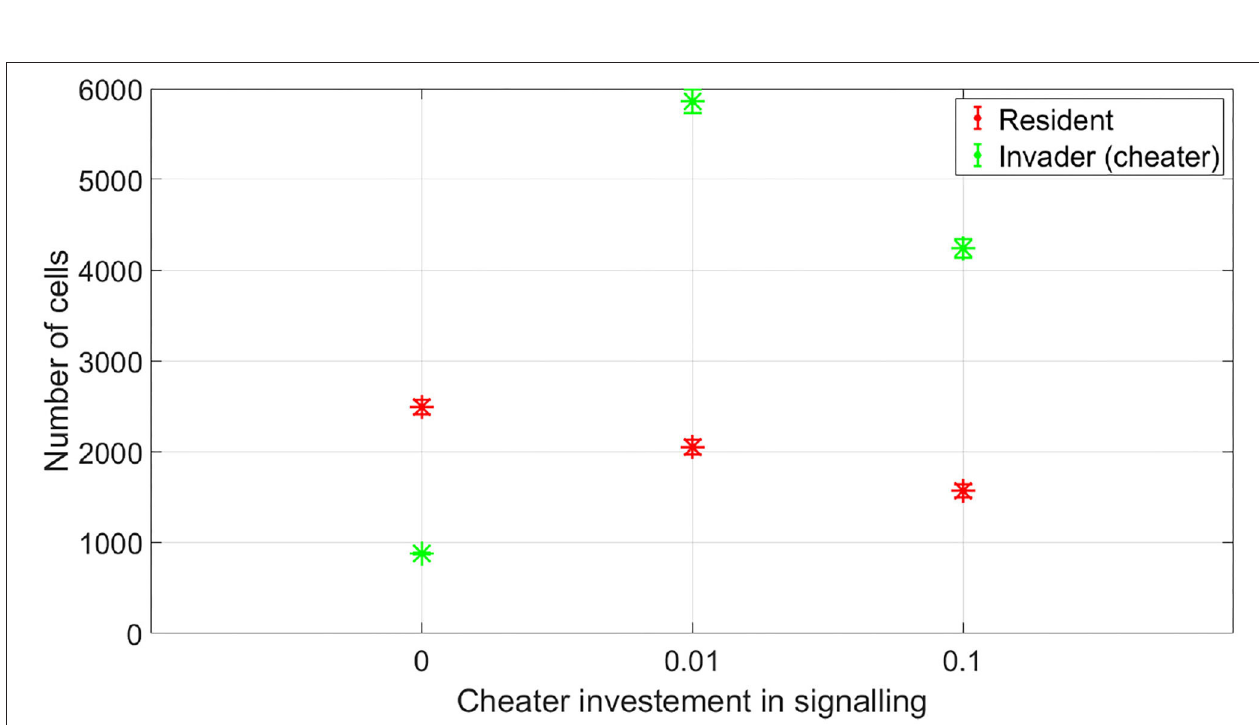
FIGURE 9 | The fitness of a non-efficient antibiotic producer vs. the resident species, when the resident species adopts a competition tolerance strategy at a low subinhibitory antibiotic concentration. While the non-efficient antibiotic producer is not capable of inflicting significant damage at the resident species, it can produce enough quantities of the antibiotic to activate the competition tolerance response of the resident species, achieving a high fitness gain in the process. The data representation is the same as Figure 4 .